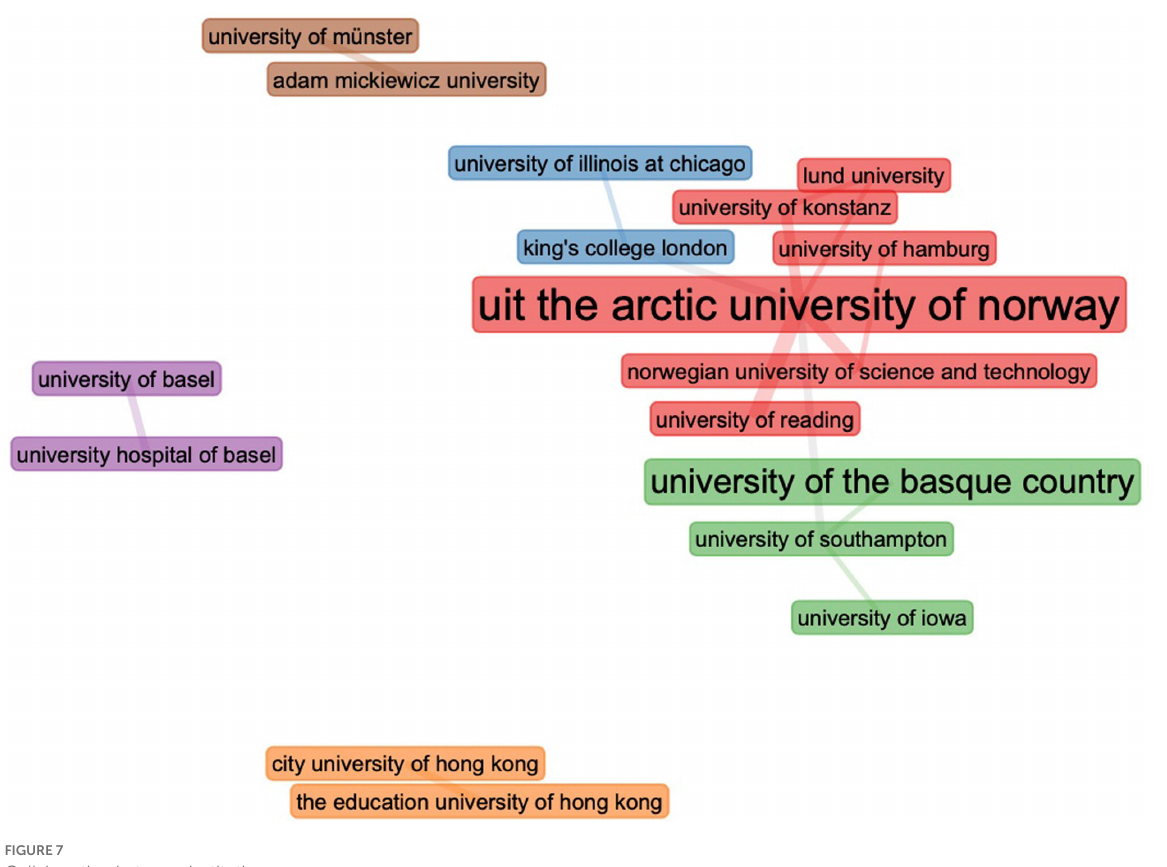
FIGURE 7 Collaboration between